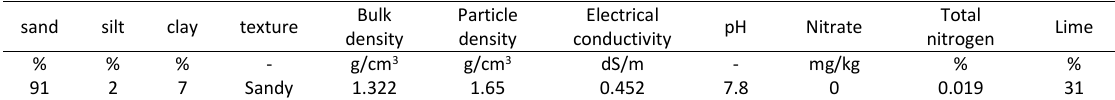
Table 1: Soil specifications used in the